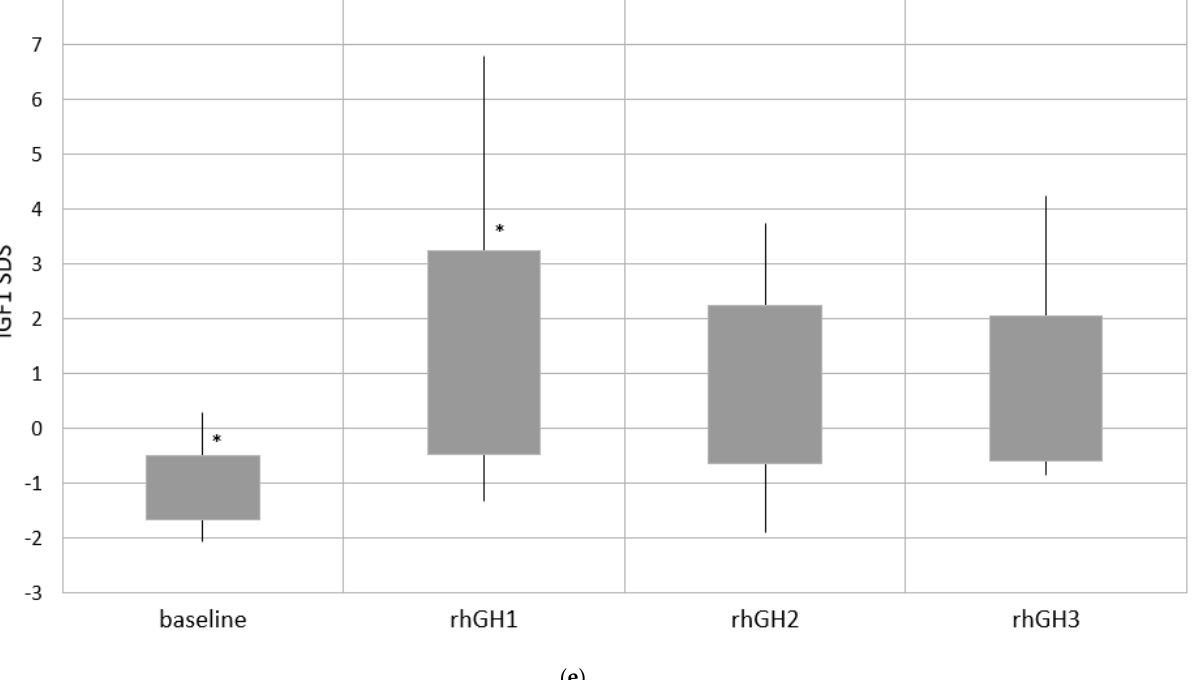
Table 4. Metabolic assessment: insulin and glucose in the OGTT, HOMA-IR and lipid profile (mean value ± standard deviation score (SDS)).